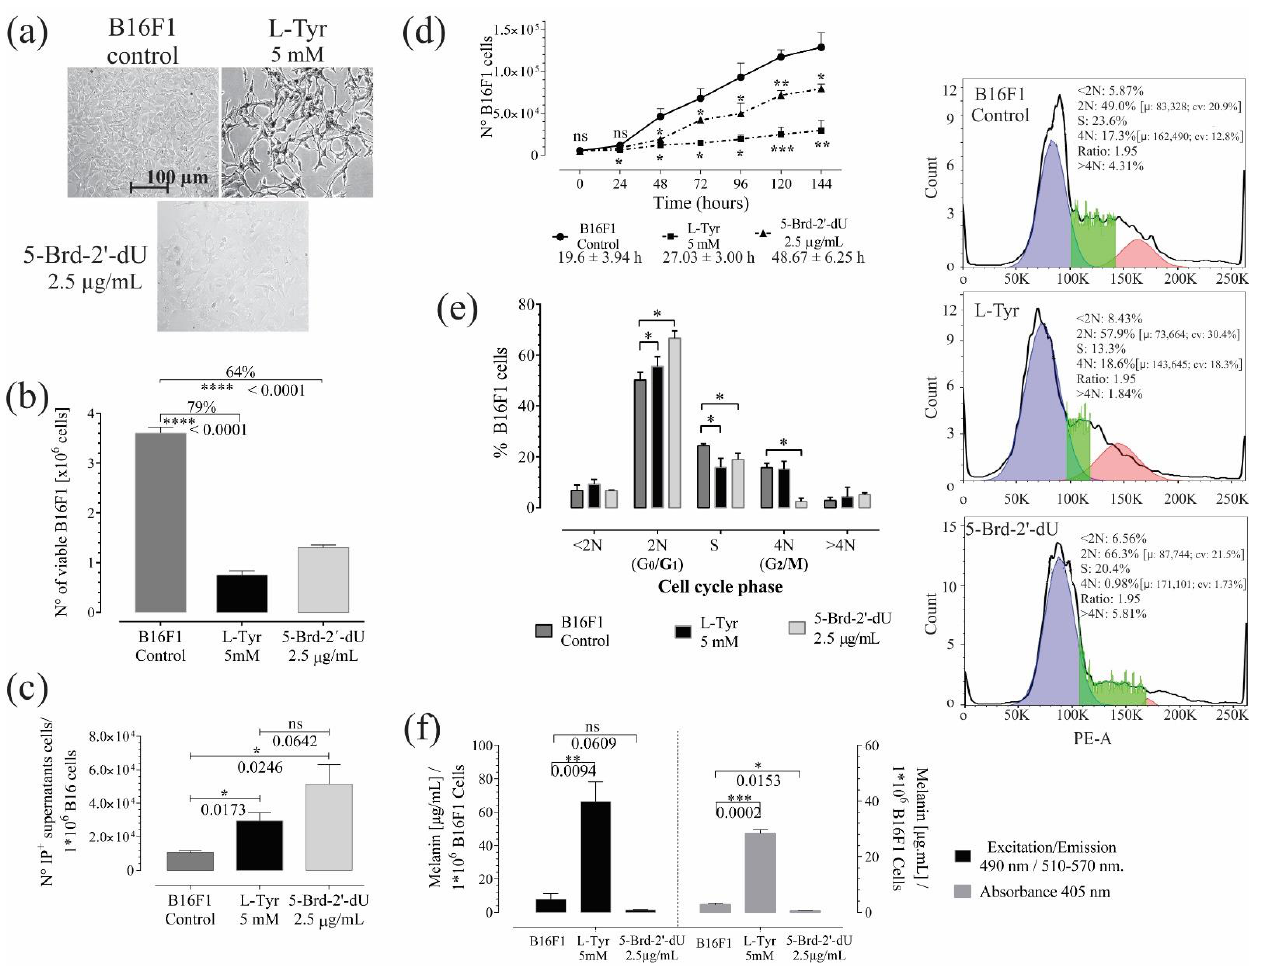
Figure 1. Exposure to L-Tyr or 5-Brd-2 (cid:48) -dU for 72 h in B16F1 cells generates a reduction in the number of cells and affects melanin concentration. ( a ) Representative photographs of B16F1 cells exposed to 5 mM L-Tyr or 2.5 µ g/mL 5-Brd-2 (cid:48) -dU after 72 h. ( b ) Quantification of the number of viable cells by Trypan Blue exclusion assay. ( c ) The number of cells in supernatants that incorporate Propidium Iodide (I.P.). ( d ) Changes in B16F1 cell number by MTT assay and population doubling times. ( e ) Frequency histograms of DNA content. Permeable cells incorporated PI; the cell cycle analysis corresponds to a univariate Gaussian distribution model. FlowJo algorithm function revealed phase S cells, ( f ) Melanin concentration from B16F1 cells after exposure to L-Tyr or 5-Brd-2 (cid:48) -dU by spectrophotometry fluorescence. The significance (*) using two-tailed multiple t -tests, and the differences were considered statistically significant for a p -value < 0.05 using Welch’s correction. significant (*) with p < 0.05, very significant (**) with p < 0.01, highly significant (***) with p < 0.001 and very highly significant (****) with p <